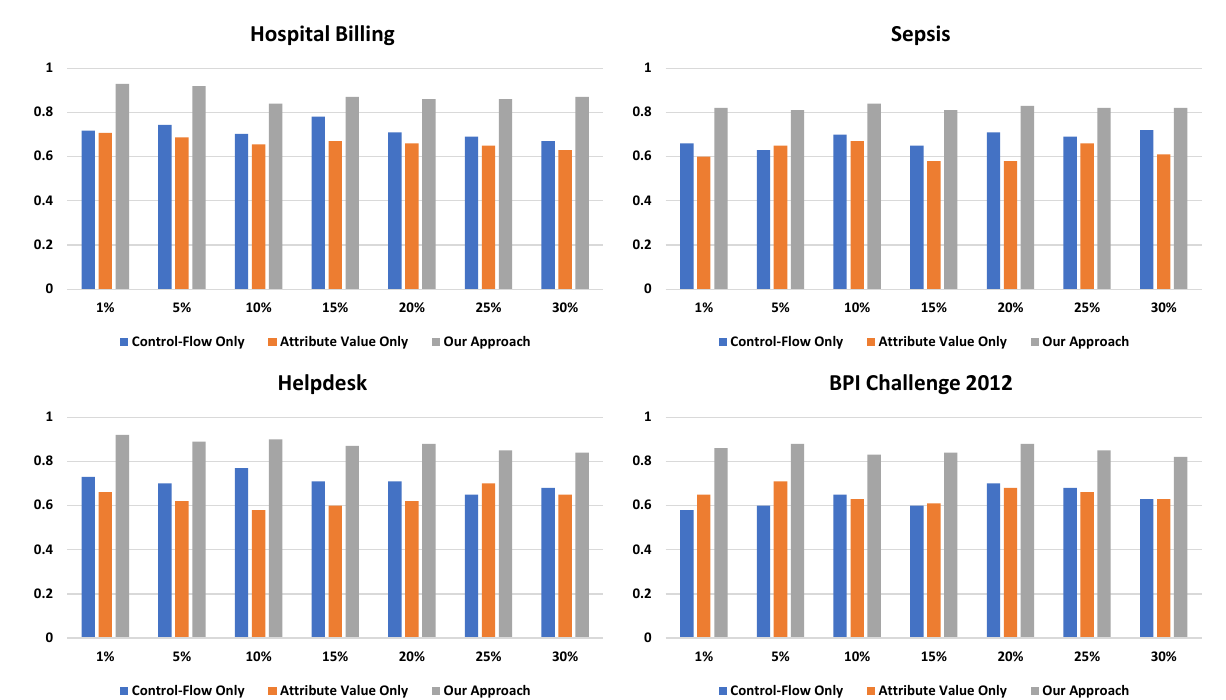
Figure 8. F-score comparisons of our framework with the baseline using four event logs. Finally, we also conducted experiments to show how redundant activity labels can im- pact the discovered process models and how our framework can be used as a preprocessing tool to repair event logs. We selected two event logs with the highest (Hospital Billing) and lowest (Sepsis Log) detection f-score for the experiments. A simple and fundamental repair mechanism was adopted. Redundant activity labels were replaced with the most similar non-redundant activity labels in event logs. A mode of advanced repair technology is left as future work. We aimed to compare the f-scores for discovered process models on original event logs (no redundant activity labels exist), problematic event logs (with redundant activity labels), and repaired event logs by using the proposed detection framework with the basic repair mechanism. We used the Inductive Miner infrequent [21] to mine process models. We conducted conformance checking between all discovered process models against the original event logs. The more conformance there was between the process model discovered from the repaired event log and the original event log, the higher the f-score achieved. We used alignment-based fitness and conformance-based precision tools in the PM4PY [48]. The f-scores for the original event logs are referenced from [15] directly. The results are presented in Table 4. We can see that the existence of redundant activity labels has a tremendous impact on the discovered process models. For instance, the f-scores drop significantly compared with the original f-scores. On the contrary, the f-scores on process models discovered from repaired event logs drop slower and remain closer to the original event log. The results indicate that our framework can be used as a preprocessing tool and help with improving the quality of process models when there are redundant activity labels in the event